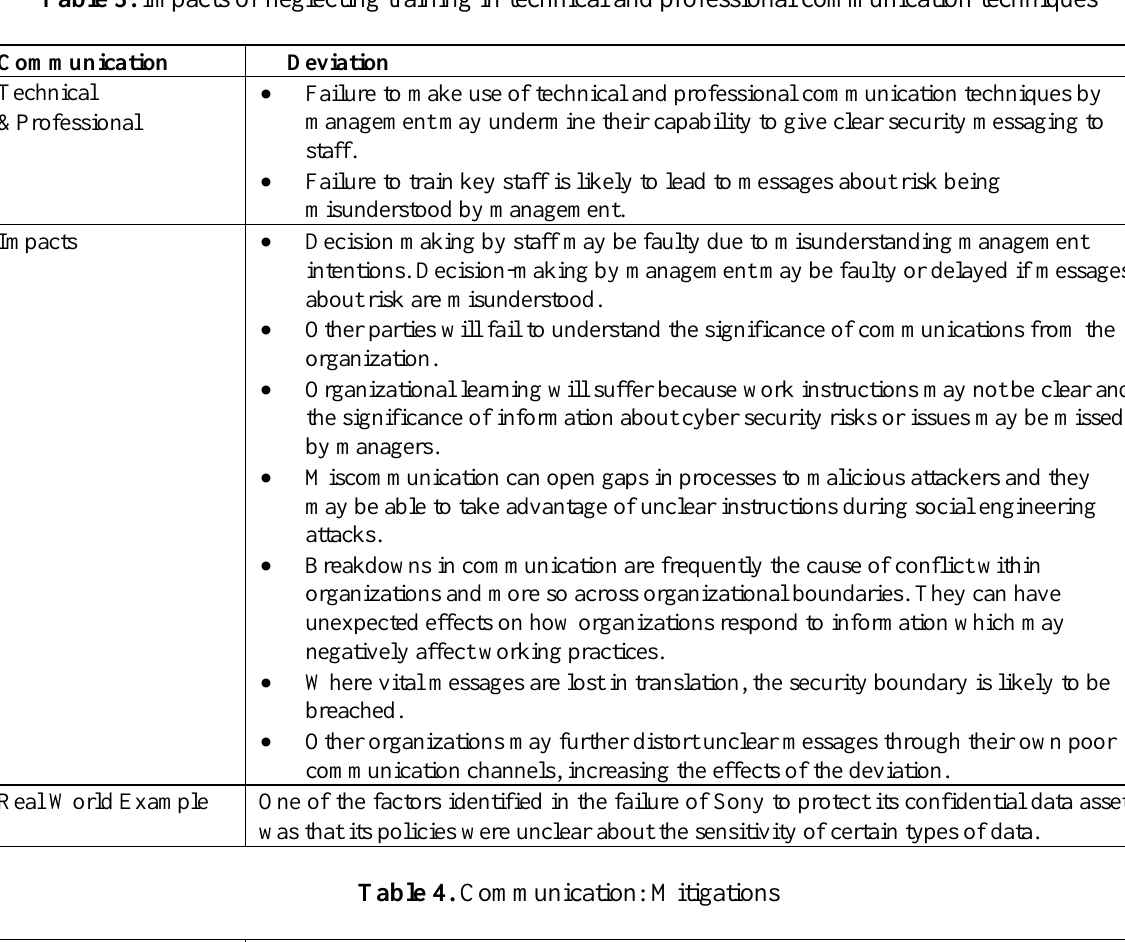
Table 3. Impacts of neglecting training in technical and professional communication techniques